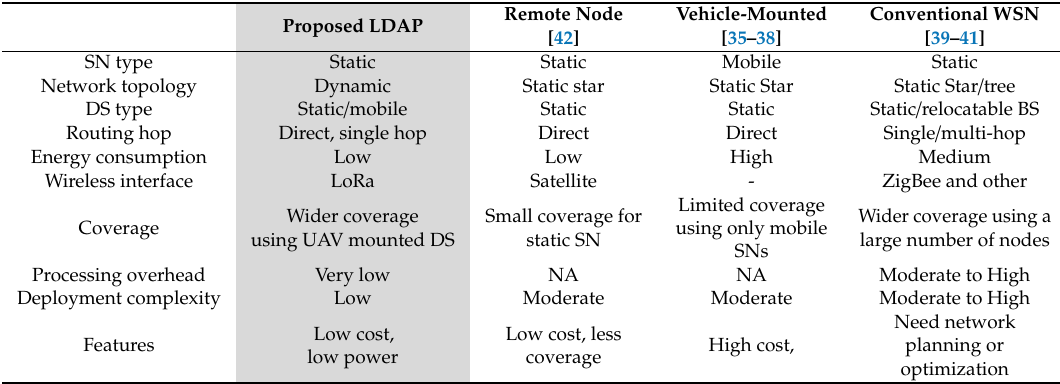
Table 6. Features of the proposed protocol and comparison with other